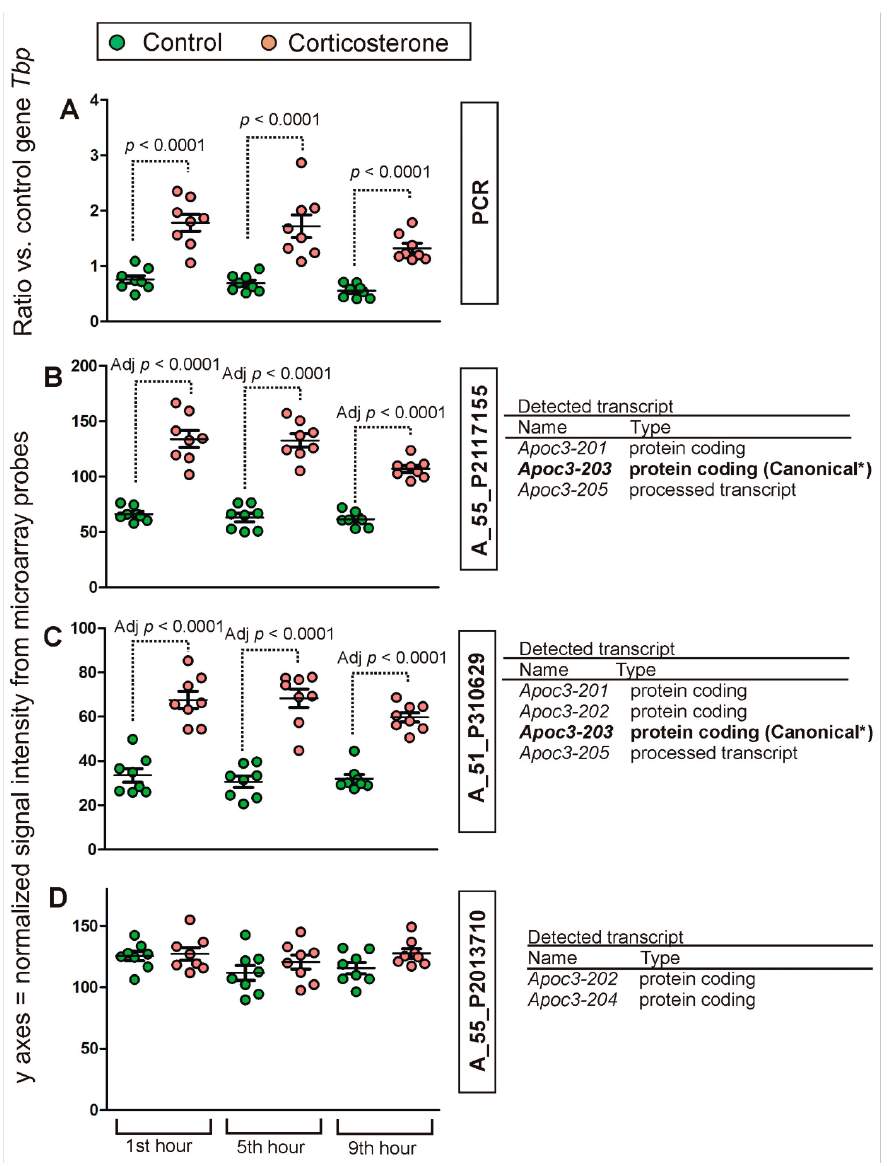
three microarray probes displayed significant differences in the comparison between the first and the second time points (first hour vs. fifth hour) while 11 probes differed between the second and the third time points (fifth hour vs. ninth hour). These additional compar- isons revealed a few additional genes (adjusted p < 0.05) that were only specific for the comparison between the first and fifth hour ( Slc15a3 ) or between the fifth and ninth hour ( Hrk and Cables1 ).